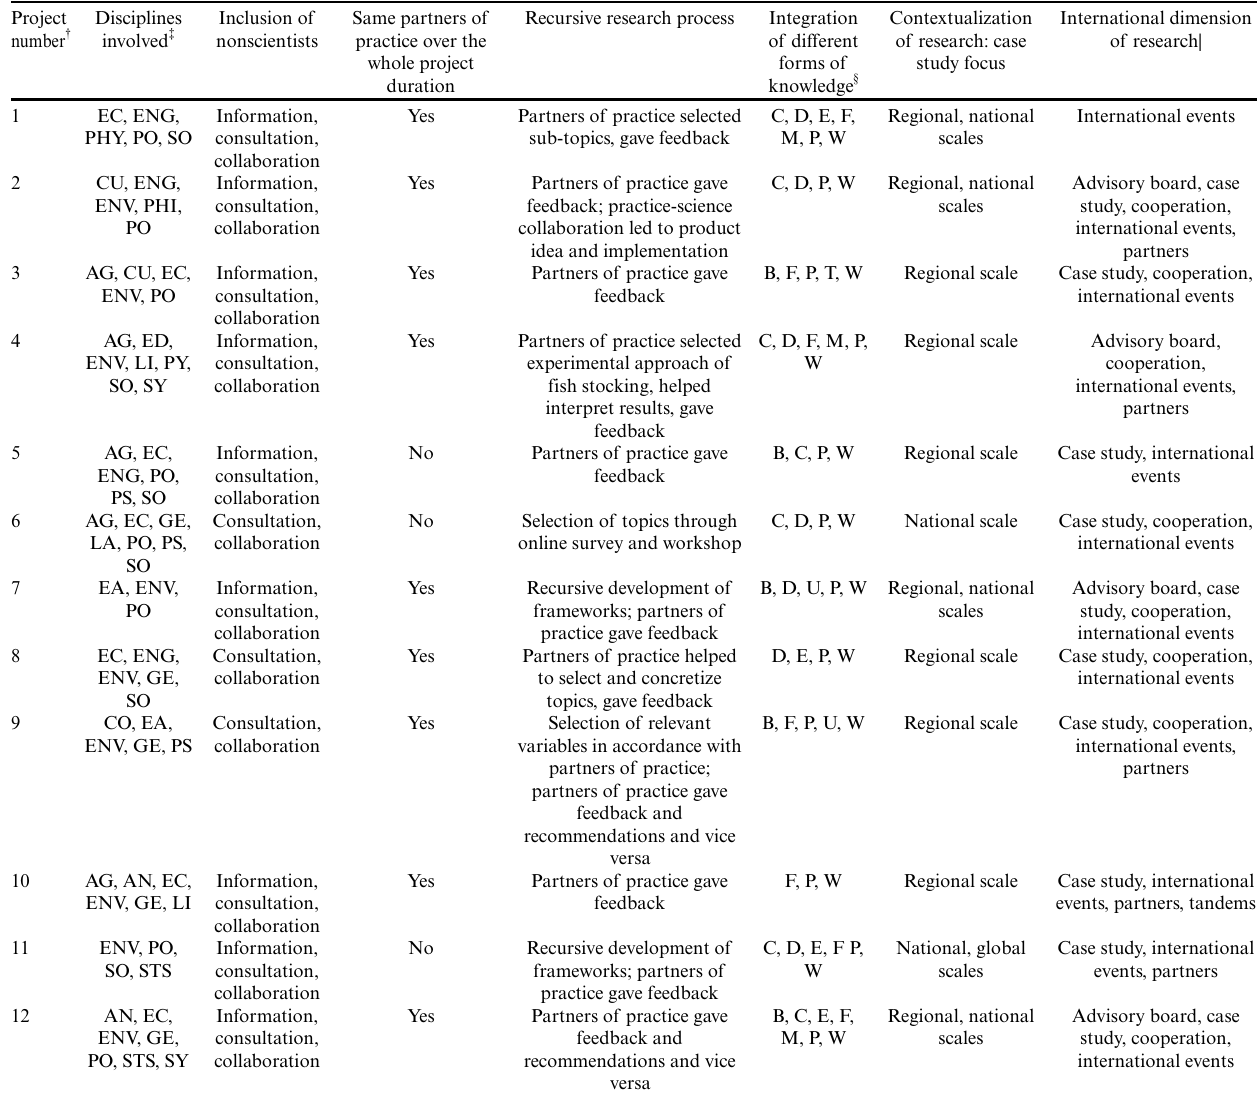
Table 3. Implementation characteristics of the 12 social-ecological research groups.